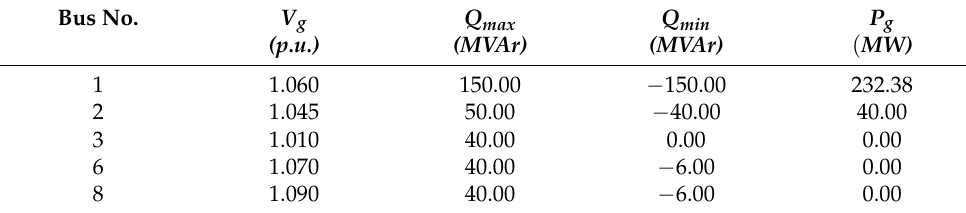
Table 6. Generator